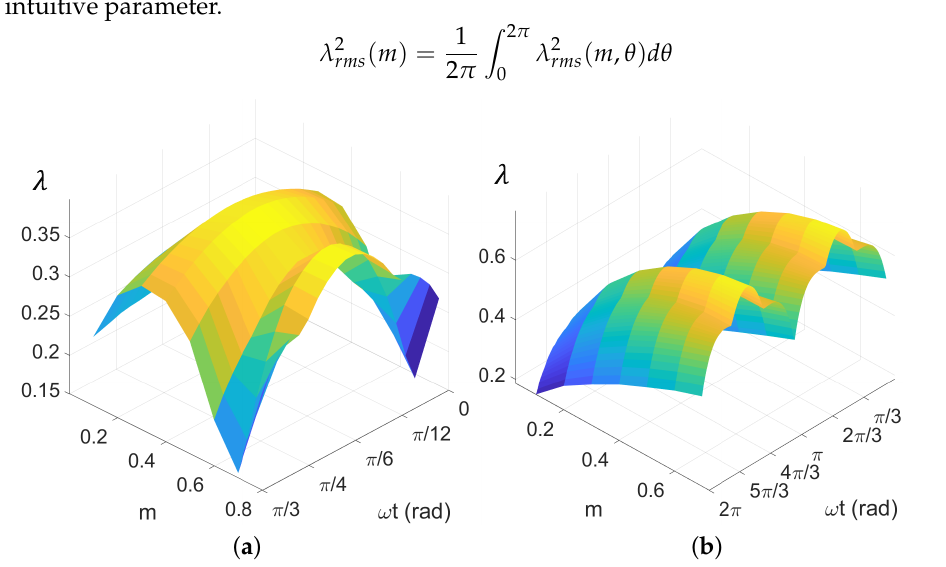
Figure 8. Harmonic flux trajectories of ( a ) conventional CBPWM in Sector I, ( b ) double modulation RCMV-CBPWM when u min is reversed in all